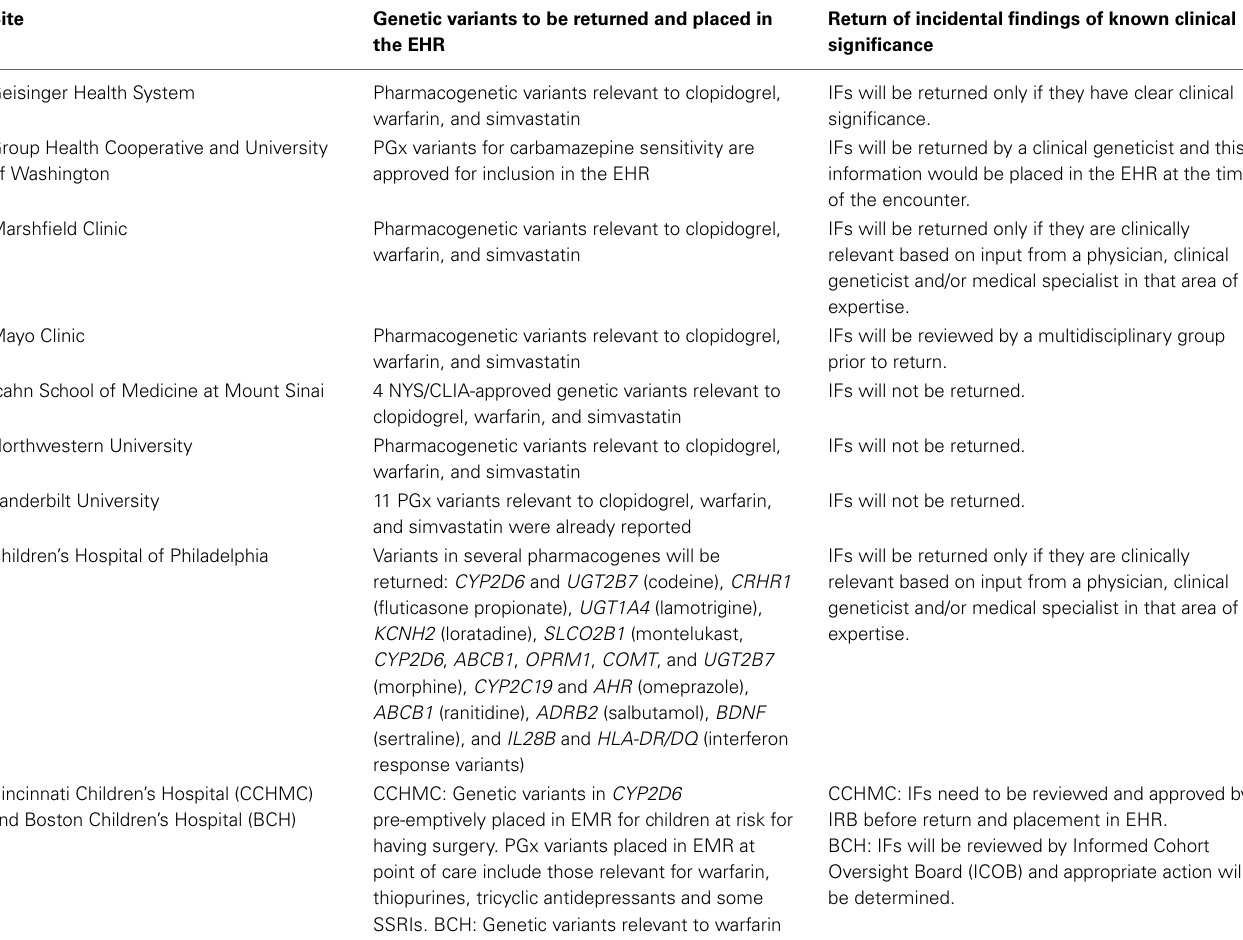
Table 3 | Return of results related to the eMERGE pharmacogenomics (PGx) projects at each of the eMERGE network sites.